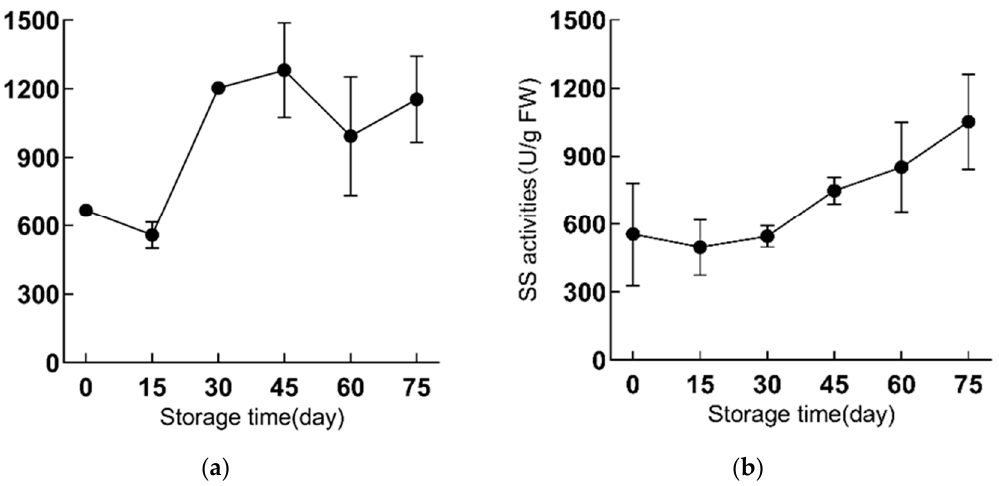
Figure 4. The changes of sucrose of ‘Fly Tiancheng’ during cold storage. ( a ) represents ‘Fly Shaohua’, ( b ) represents ‘Fly Tiancheng’. SPS and SS activity has three biological repeats. SPS, sucrose phosphate synthase (EC 2.4.1.14); SS, sucrose synthase (EC 2.4.1.13).